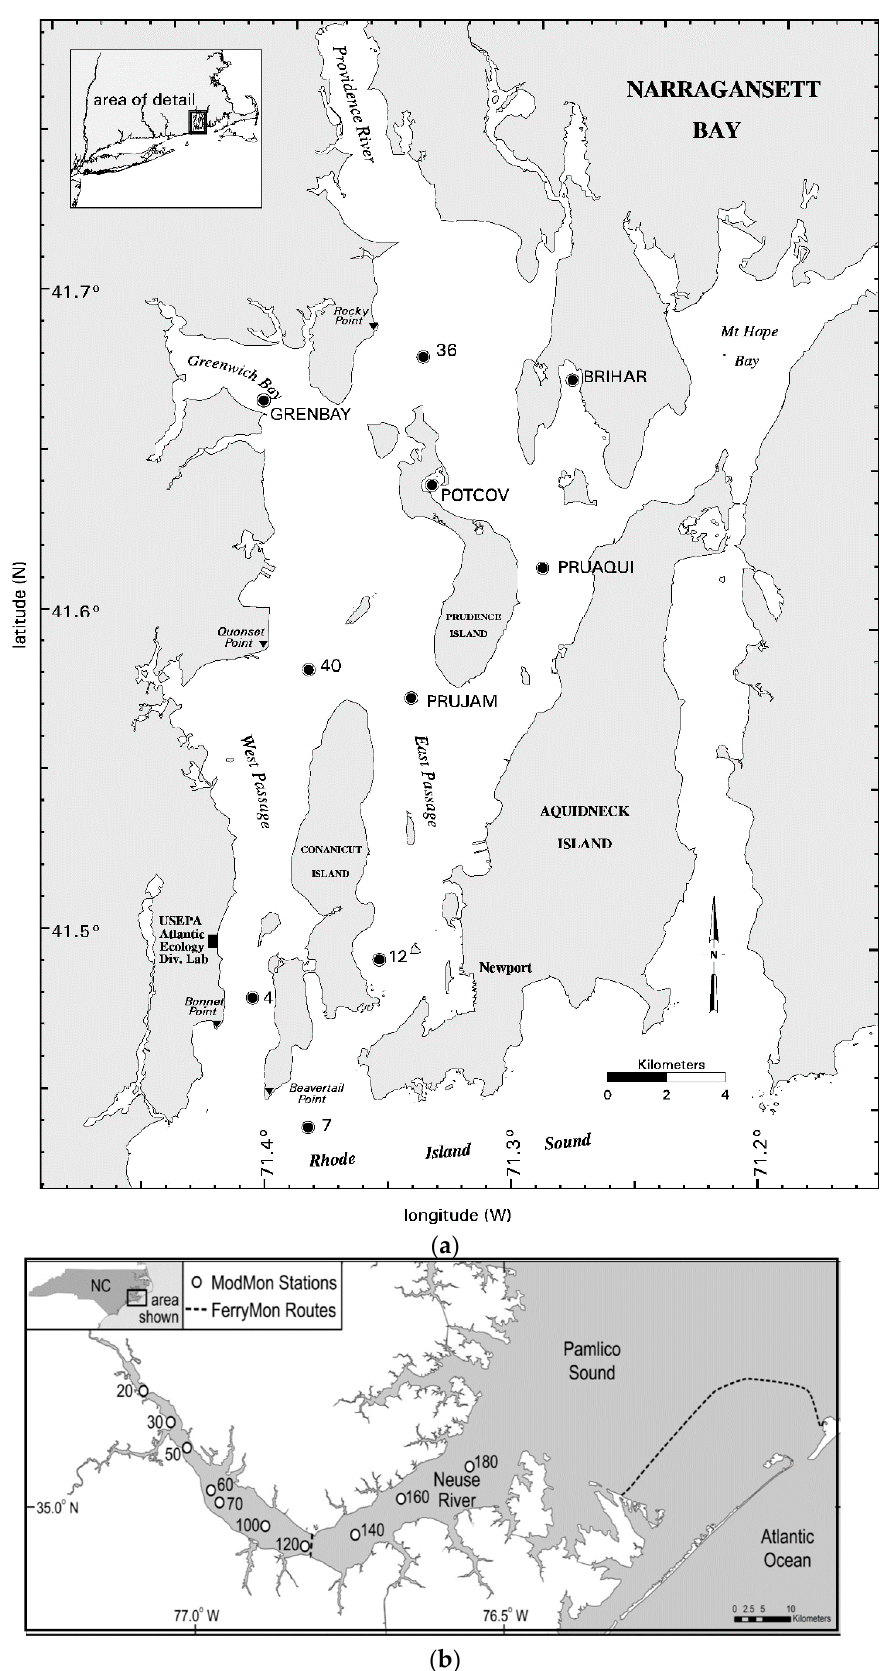
Figure 1. Cont. Figure 1.